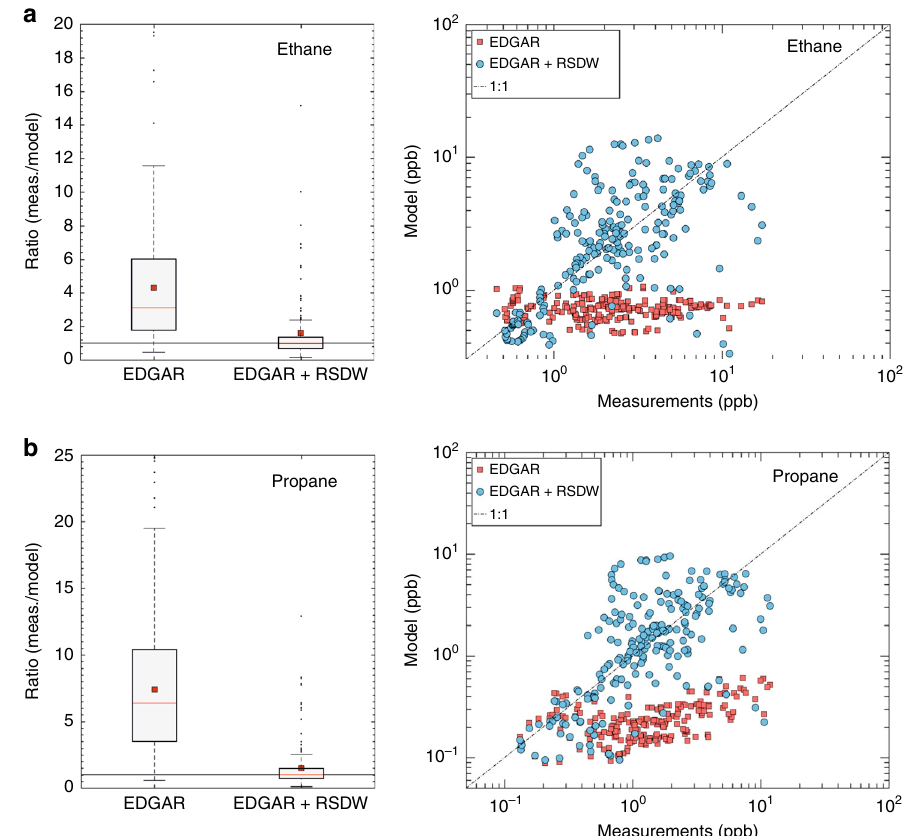
Fig. 3 Model simulations and measurements over the northern Red Sea. Ethane ( a ) and propane ( b ) relationships are illustrated for the EDGAR v4.3.2 inventory and compared with the addition of the Red Sea Deep Water (RSDW) emissions in the inventory input. The boxplots illustrate the median with red line and the mean with red squares. The bottom and top edges of the box indicate the 25th (q1) and 75th (q3) percentiles, respectively. The boxplot draws points as outliers if they are greater than q 3 + w × ( q 3 − q 1) or less than q 1 − w × ( q 3 − q 1). The whiskers correspond to ±2.7 σ and 99.3% coverage if the data are normally distributed.